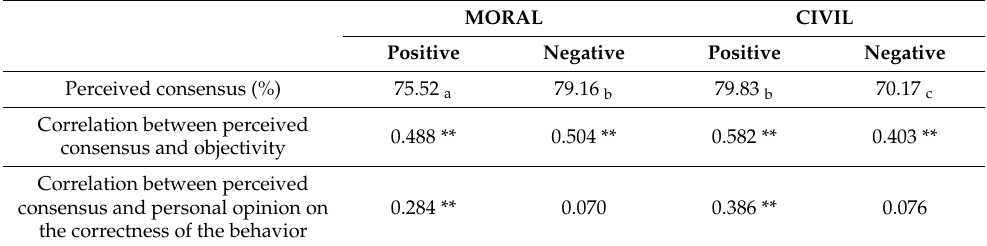
Table 2. Estimated percentage of Spaniards who would agree with the participant on the attribution of moral truth value for moral and civil behaviors and correlation with the attributed objectivity and agreement with personal opinion. MORAL CIVIL Positive Negative Positive Negative Perceived consensus